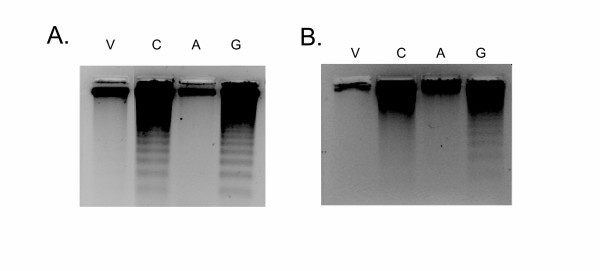
γ-Tocopherol treatment results in DNA laddering in HCT-116 cells (Panel A) and SW480 cells (Panel B) following a 100 μM tocopherol treatment for 48 hours (V = vehicle, C = camptothecin (+) control, A = alpha tocopherol, G = gamma tocopherol).